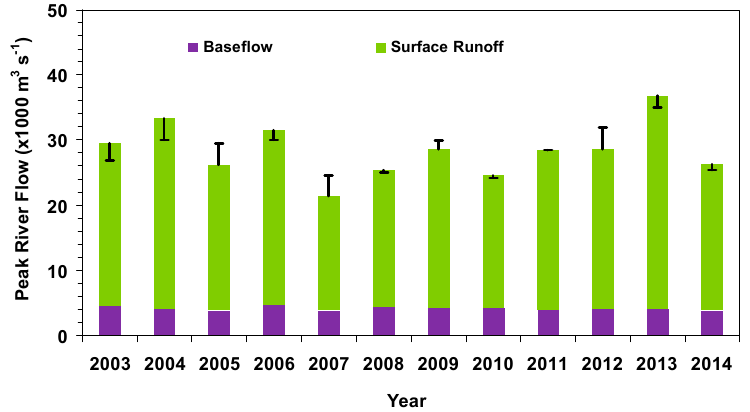
Figure 8. The leave-one-out cross-validation (LOO-CV) results for peak river flow forecasts. The error bar is the difference between forecasted and observed peak river flows for each year.